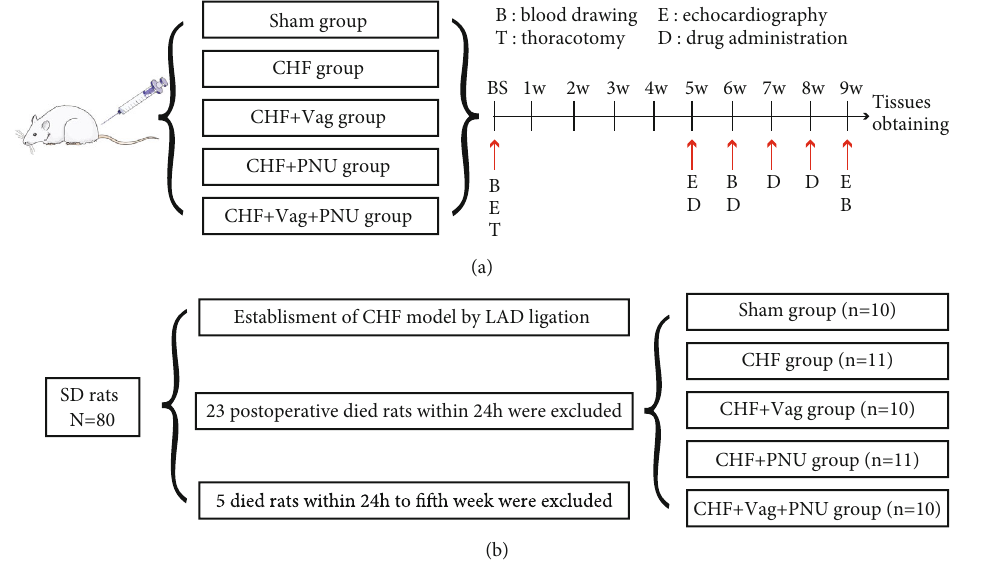
Figure 1: Flow chart of the experiment process: (a) study protocol diagram; (b) grouping